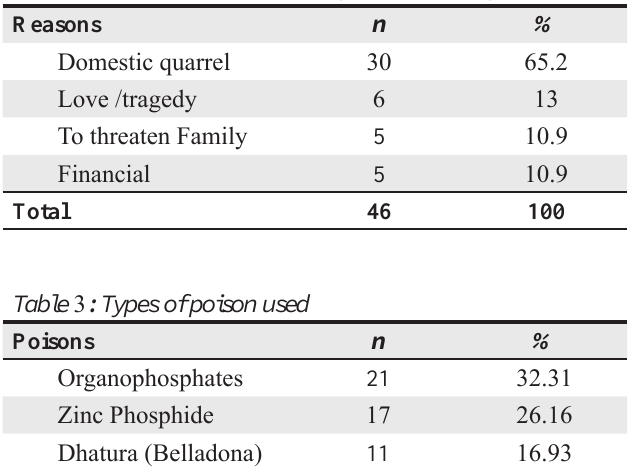
Table 2 : Reasons for intentional poison consumption